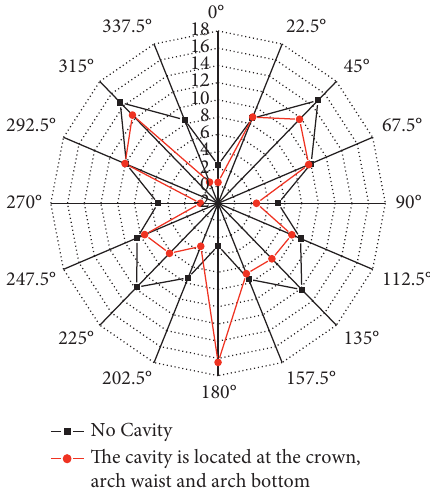
Figure 32: Coefficient of the safety of vault, arch waist, and cavity tube section behind the arch